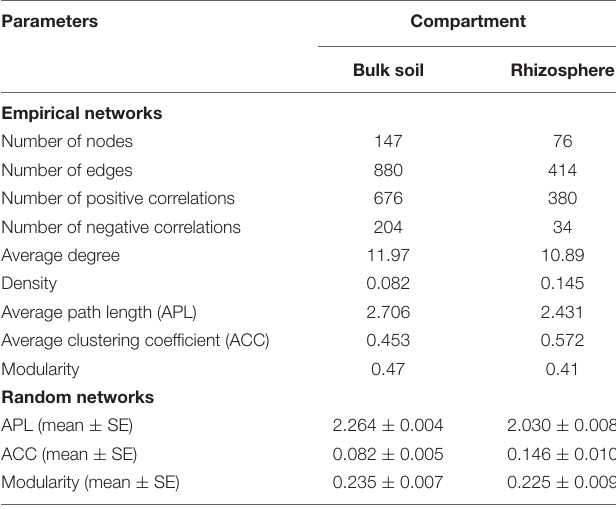
TABLE 1 | Topological properties of the empirical microbial co-occurrence networks in the bulk soil and rhizosphere of soybean fields in China and their associated random